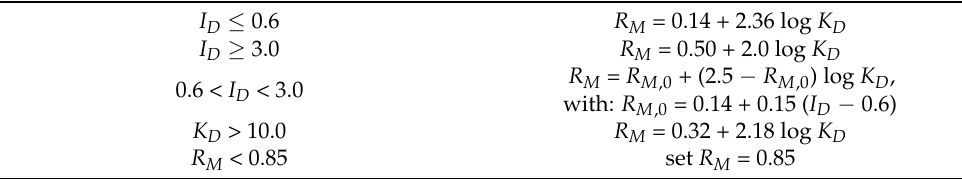
Table 1. Determination of R M correction factor